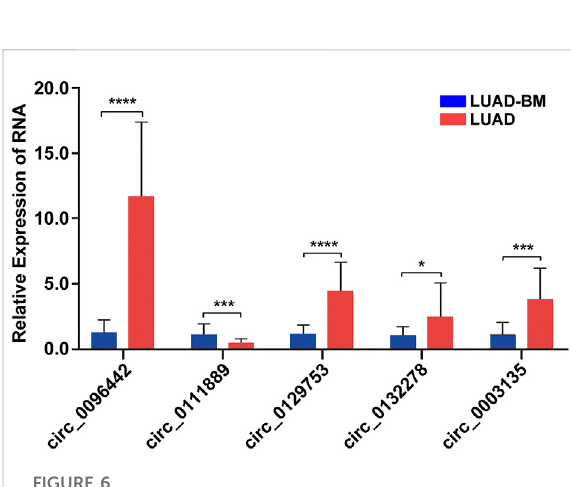
FIGURE 6 Validation of the fi ve-candidate circular RNAs. The relative levels of the fi ve circRNAs is con fi rmed by qRT – PCR. LUAD-BM, lung adenocarcinoma with bone metastasis; LUAD, lung adenocarcinoma; circRNAs, circular